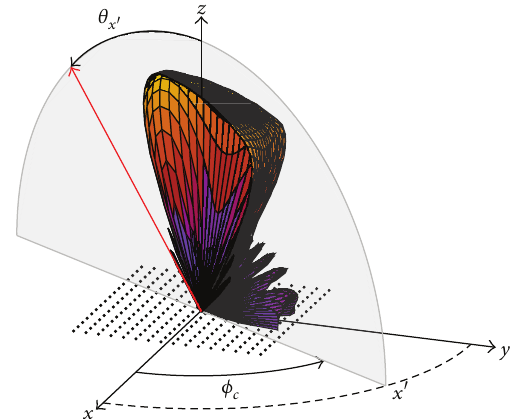
Figure 7: The response of a collapsed equivalent linear array is identical to the planar array’s response in the 𝑥 󸀠 𝑧 -plane (i.e., a 𝜙 - cut), shown here for the 16 × 16 SRA 𝑃 𝑟𝑦 pattern, evaluated in = 63.4349 ∘ 𝜙 𝑐